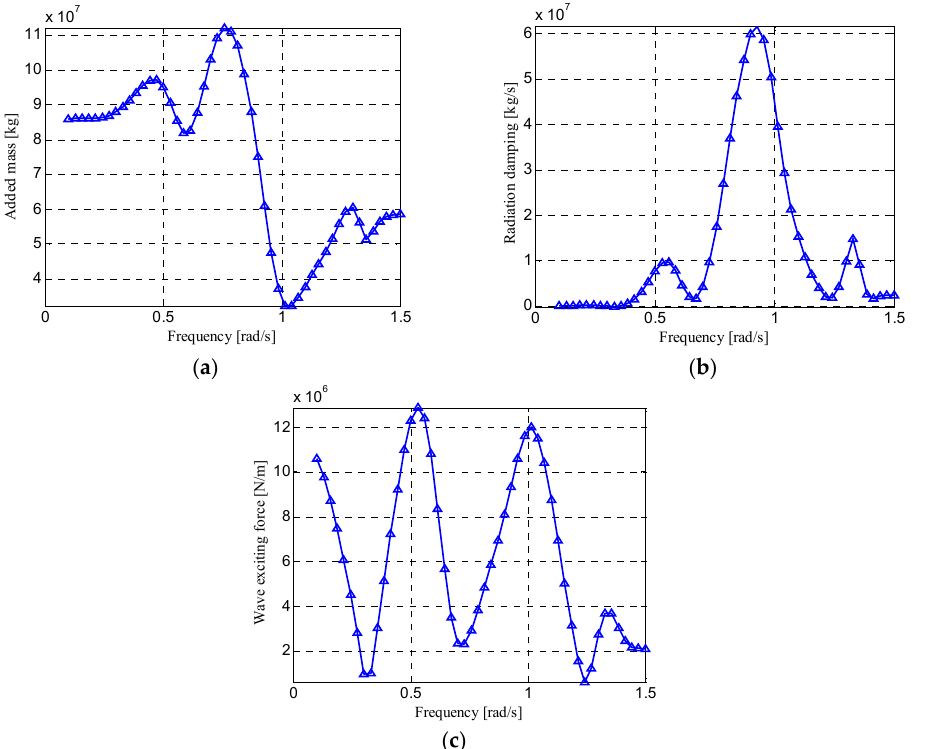
Figure 5. ( a ) Added mass coefficients of the semi ‐ submersible platform in the heave motion direction; ( b ) radiation damping coefficients of the semi ‐ submersible platform in the heave motion direction; ( c ) wave exciting force amplitudes of the semi ‐ submersible platform under 1 meter amplitude regular waves in the heave motion direction.